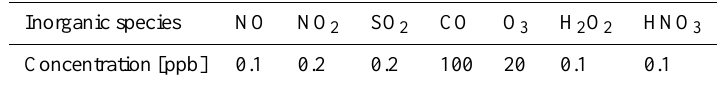
Table 1. Initial concentrations applied to all model simulations.